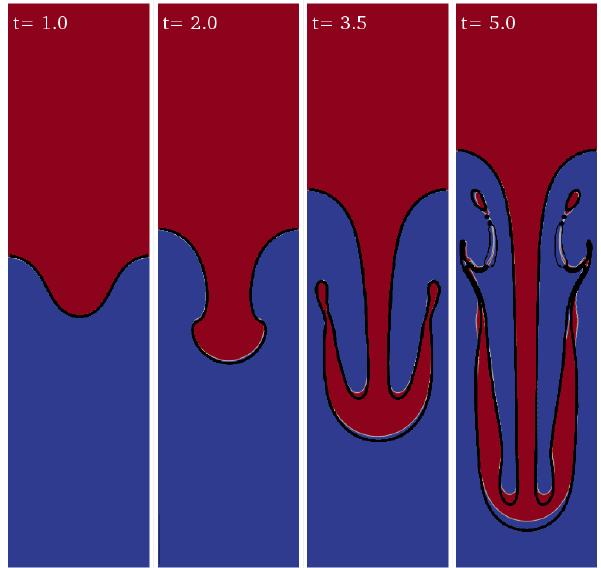
Figure 4. Rayleigh–Taylor instability ( A = 0 . 5 , Re = 256) com- puted with the OpenFOAM solver interFoam . The density field (color-coded) is compared with the density contours in He et al. (1999) (black